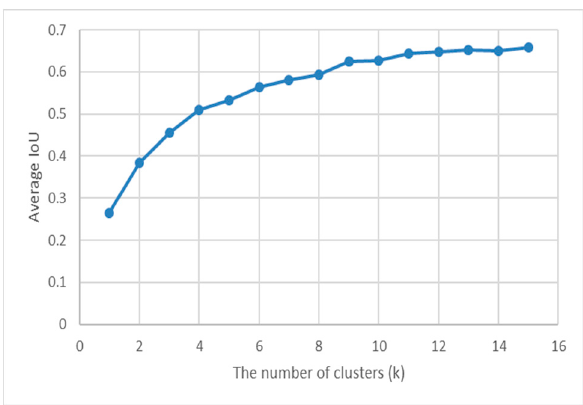
Figure 3. Clustering box dimensions on ‘InST_detection’ Dataset. The horizontal axis indicates the number of clusters, and the vertical axis shows the corresponding average IoU.